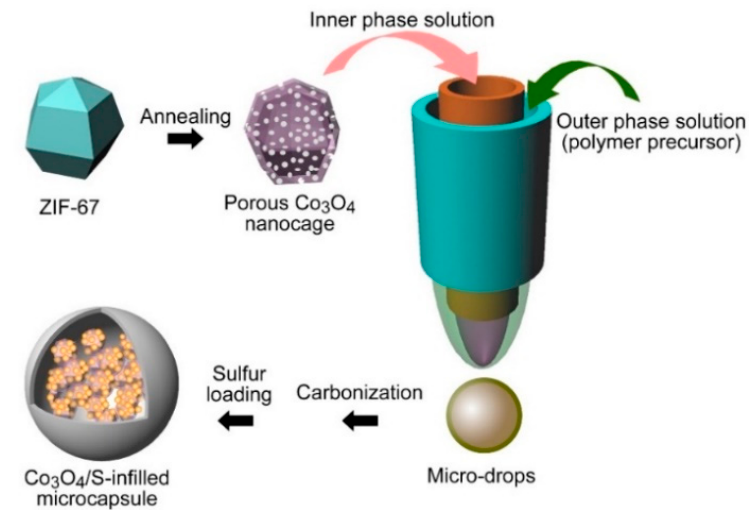
Figure 1. Microfluidic preparation of Co 3 O 4 /S-infilled